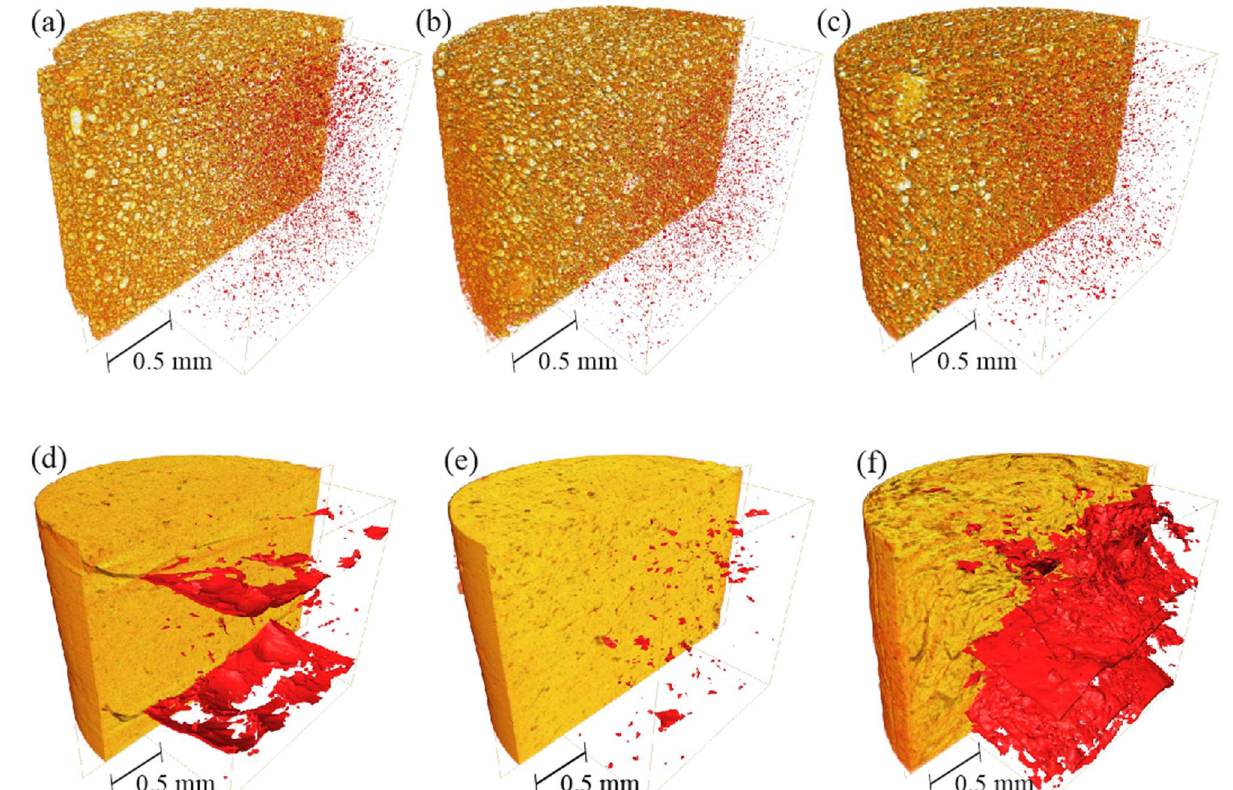
Figure 2. 3D images of dried sand and silty clay: in air without heating ( a , d ); in a conventional oven ( b , e ); in a microwave oven ( c , f ). Pores and fractures are shown in red. The structure of the sand is heterogeneous and consists of uniformly dispersed grains and pores (shown in red). In the silty clay, air drying produced few fractures, CO drying (Figure ure 2a).